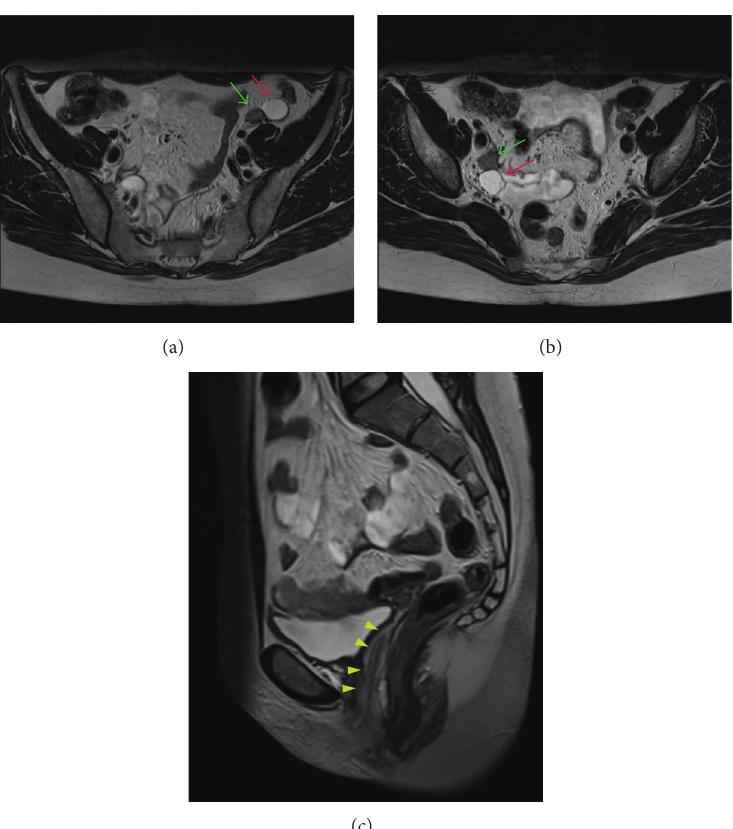
Figure 1: A 34-year-old female with CAIS syndrome. The axial T2-weighted images ((a) and (b)) show a left testis along the left external iliac artery and a right testis in the right obturator canal (green arrows) with adjoining cysts (red arrows). Sagittal image (c) shows absence of M¨ullerian structures and presence of the lower vagina (yellow arrowheads) (3T magnetic resonance imaging. Axial 4 mm fast T2-weighted images, TR/TE 5030/119ms; sagittal 5mm HASTE-sequence, TR/TE 6500/89).